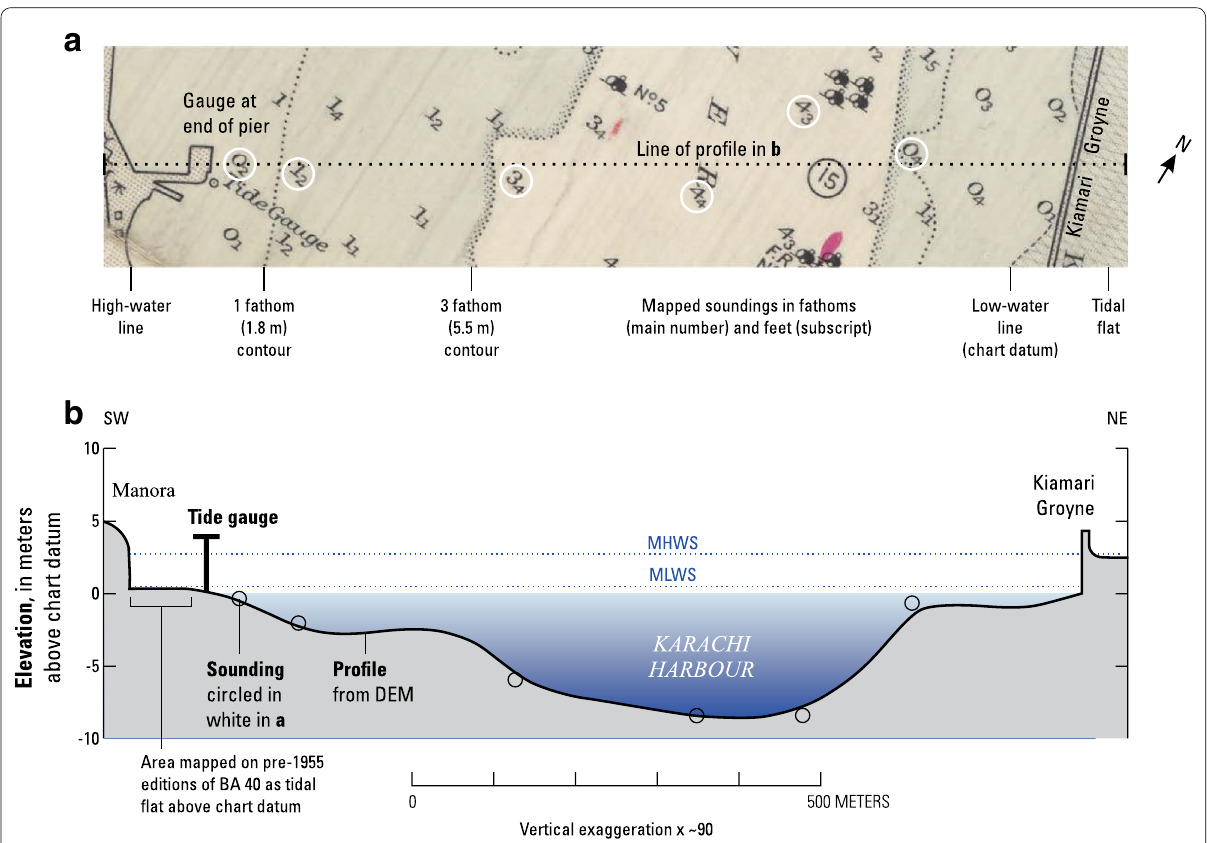
Fig. 6 Lower Karachi Harbour in the area where the tidal observatory was located in 1945. a Excerpt from nautical chart of 1955, showing soundings made with in the first 8 years after the 1945 Makran tsunami. b Profile made from preliminary DEM and compared with nearest